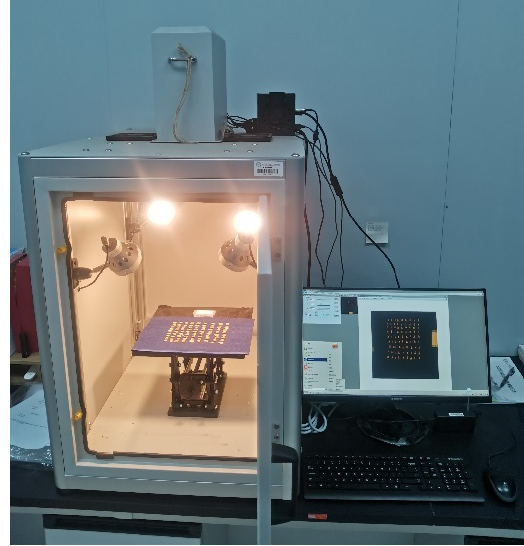
Figure 1. Hyperspectral imaging system physical map.